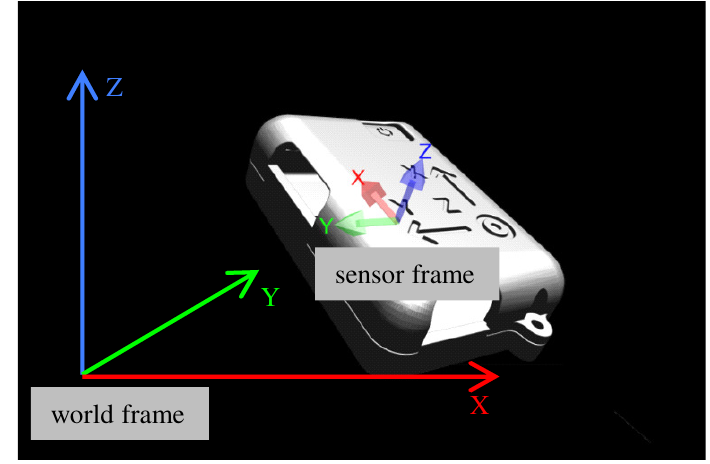
Figure 3. Sensor and world